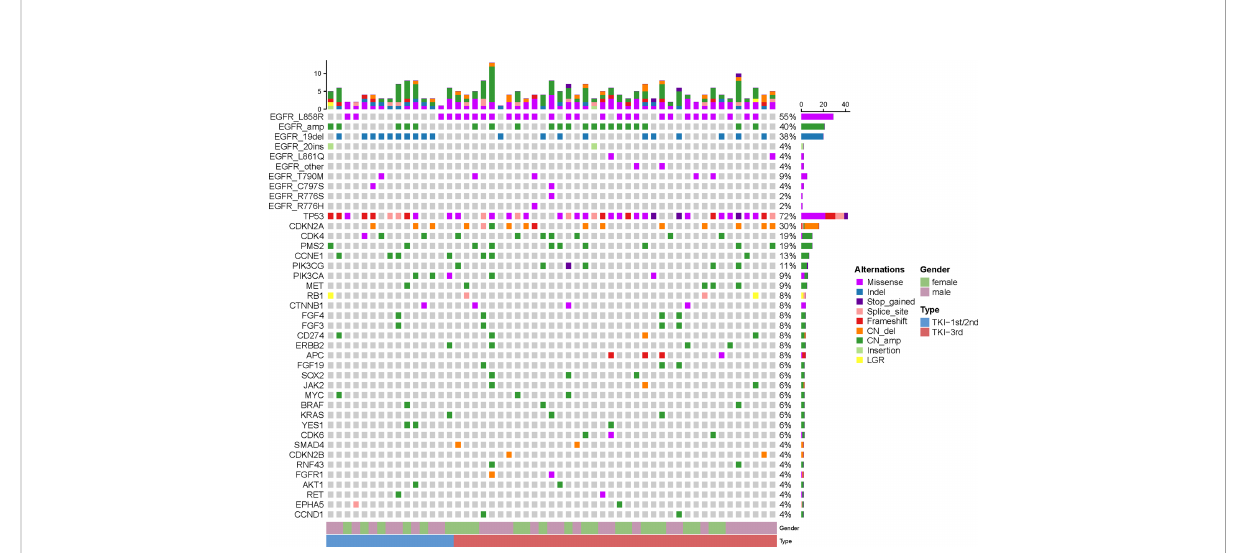
FIGURE 1 Next-generation sequencing results of 53 cerebrospinal fl uid samples taken from non-small cell lung cancer patients with leptomeningeal metastases. The top bar shows the overall number of mutations in each patient. The right-side bar shows the percentage of patients harboring a speci fi c mutation. Different colors denote different types of mutation. The bottom bar denotes patients grouped by gender or previous epidermal growth factor receptor tyrosine kinase inhibitor treatment